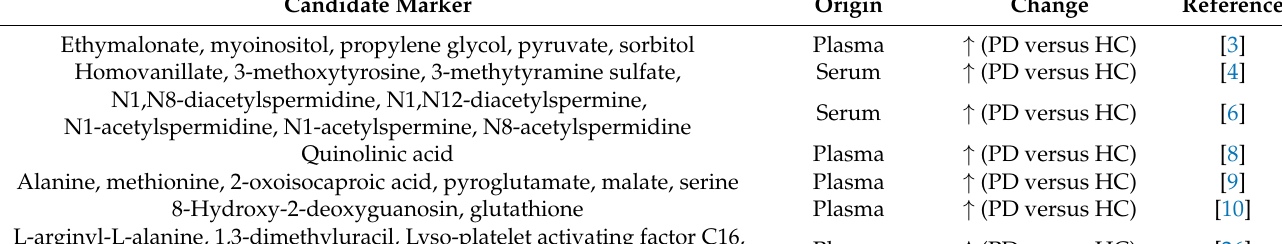
Table 3. Potential metabolite biomarkers for Parkinson’s disease in previous literature. Candidate